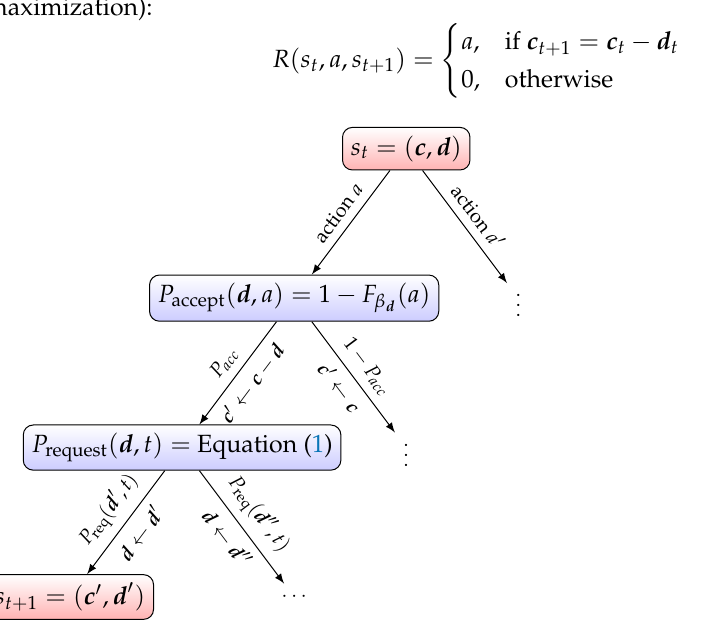
Figure 2. The structure of the transition function τ . Given state s t , the probability of getting to the next state s t + 1 is given by multiplying the probabilities along the edges. States are the decision nodes (in red), chance states are in blue and contain the definition of the probability used on